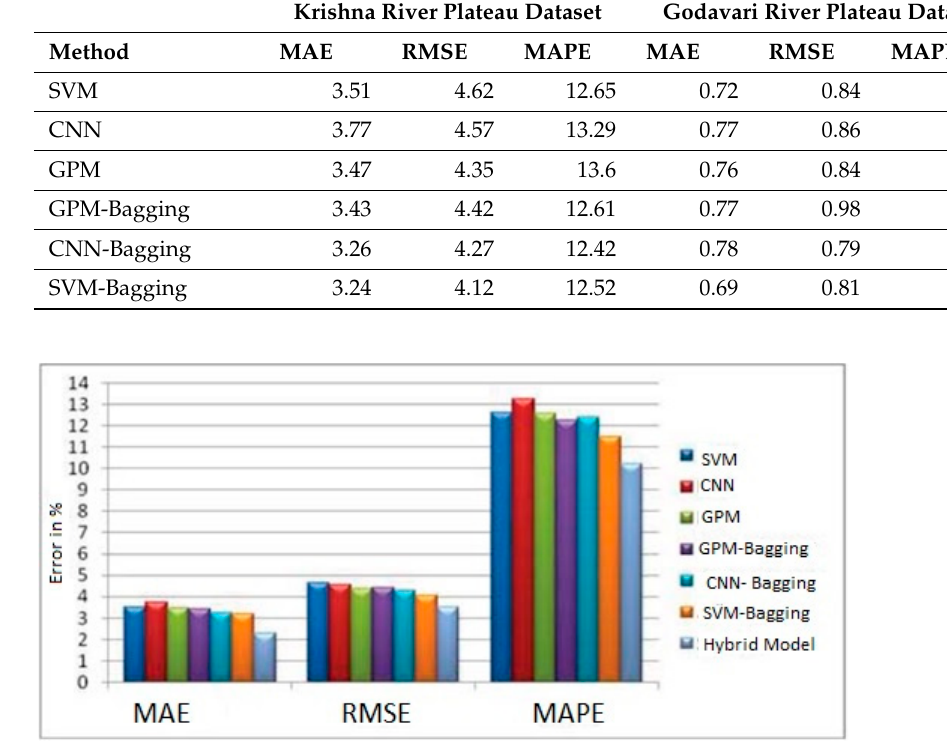
Figure 13. Performance of the various classi fi ers with the proposed model.